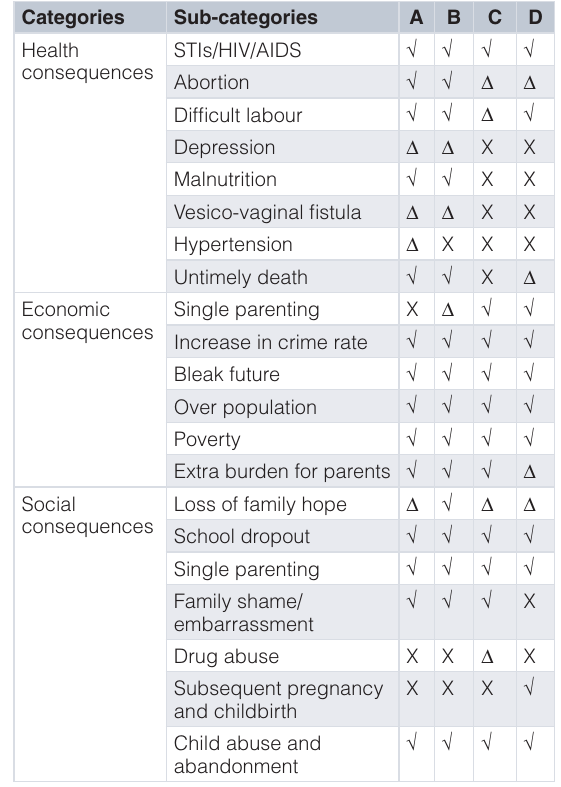
Table 3. Participants’ perceived consequences of teenage pregnancy and child bearing. To compare the responses of the samples, the following grading scale was used: a total number of 10 responses and above (n = 20) are indicated a yes √ , indicating that the majority of the sample had the same perception; 9-5 responses are indicated with, Δ indicating that there was not a consensus perception in the sample; and 0-4 responses from the sample were indicated with an x.